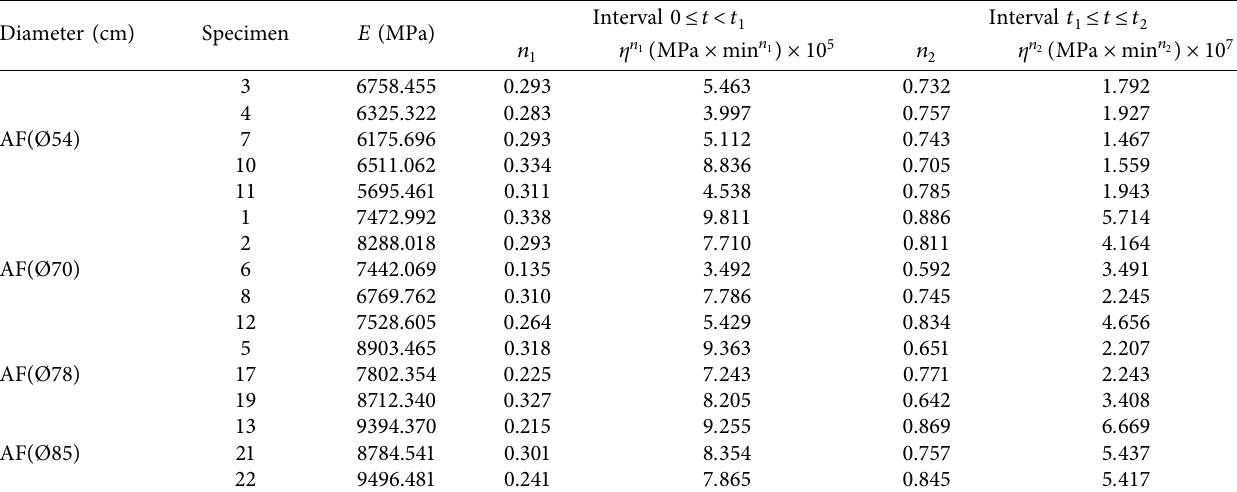
Table 11: Summary of 10-hour MF creep parameters per diameter.